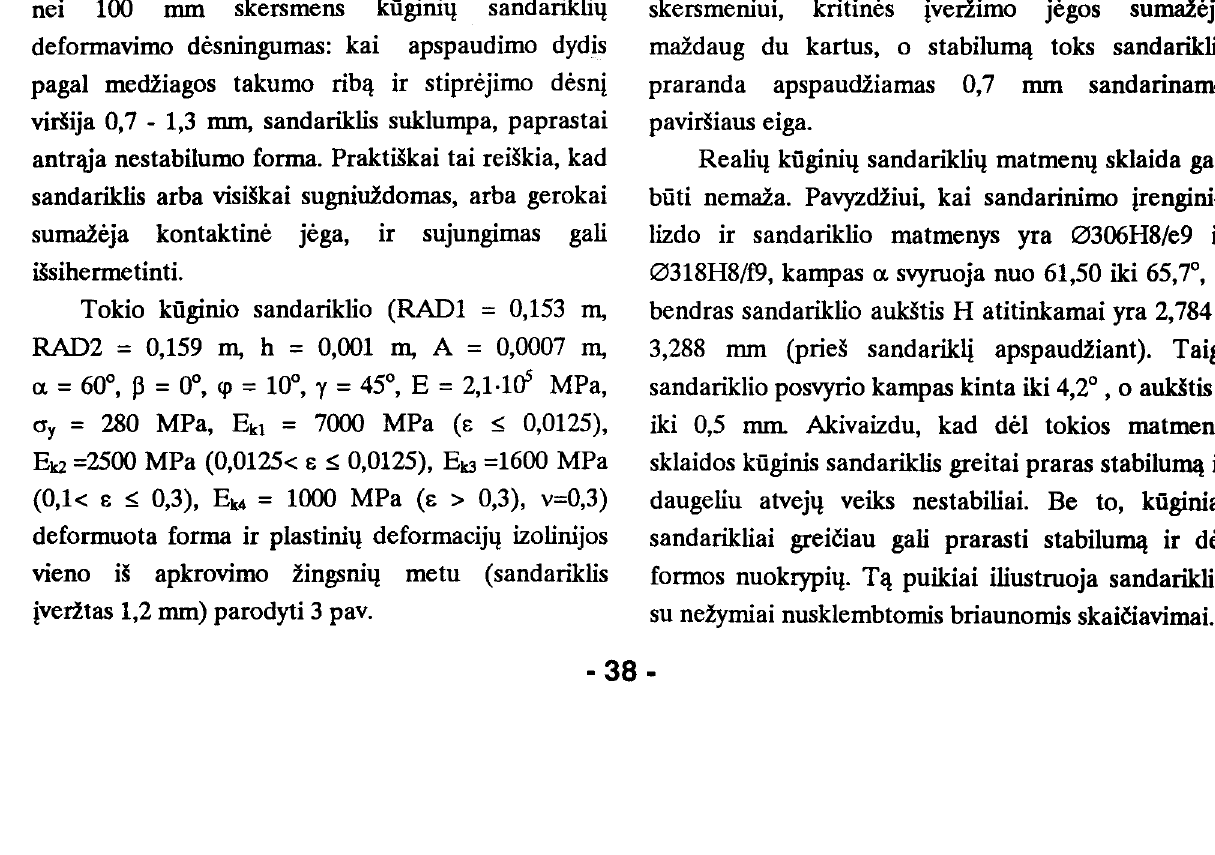
Fig 2. The relation between contact force and deformation in conical seal